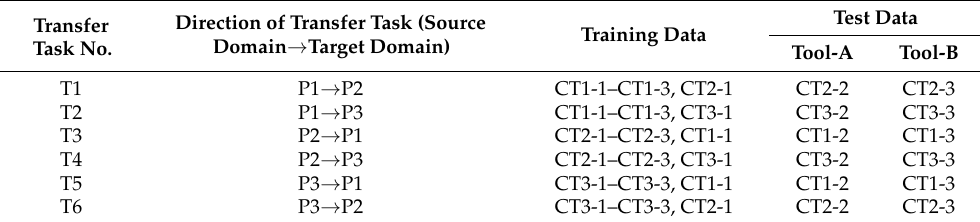
Table 4. Training and test data settings under different transfer tasks.